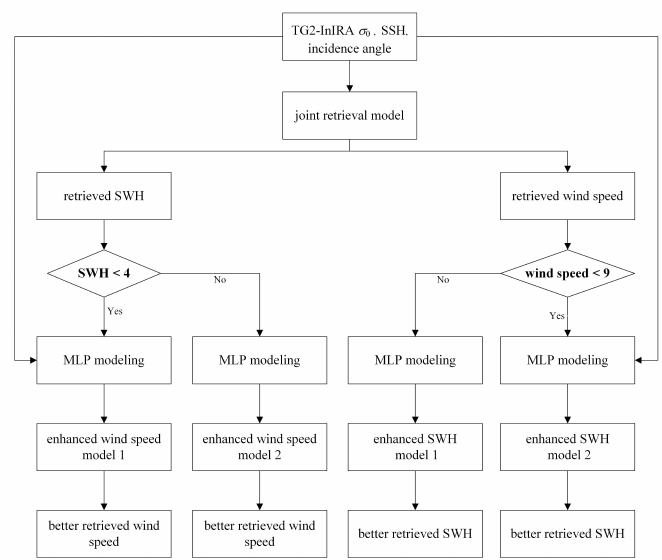
Figure 13. Block diagram of the enhanced joint retrieval method.